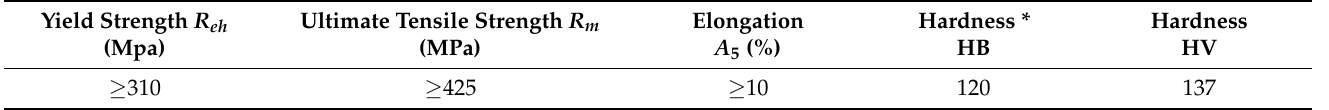
Table 1. Chemical composition of AA2024-T351 base materials, data from [42]. Chemical Composition Al wt. % Table 2. Mechanical properties of AA2024-T351 base materials, data from [42]. Yield Strength R eh